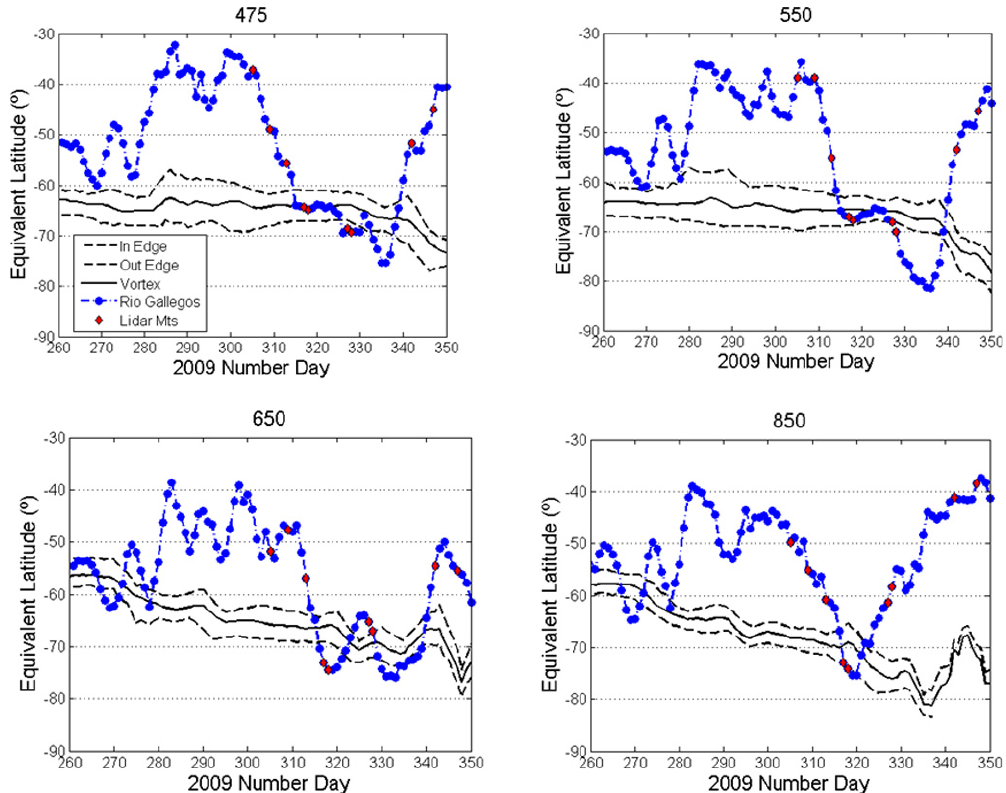
Fig. 8. Temporal evolution of equivalent latitude for the vortex limit positions (black line), inner and outer vortex edge (dashed lines), named as “In Edge” an “Out Edge”, respectively, and the R´ıo Gallegos station (blue circles) at four isentropic levels (475, 550, 650 and 850K). Red diamonds indicate the lidar measurements considered in this study. Table 4. Classification of lidar measurements with respect to vortex position at different isentropic levels. Measurement Date Day number 475K 550K 650K